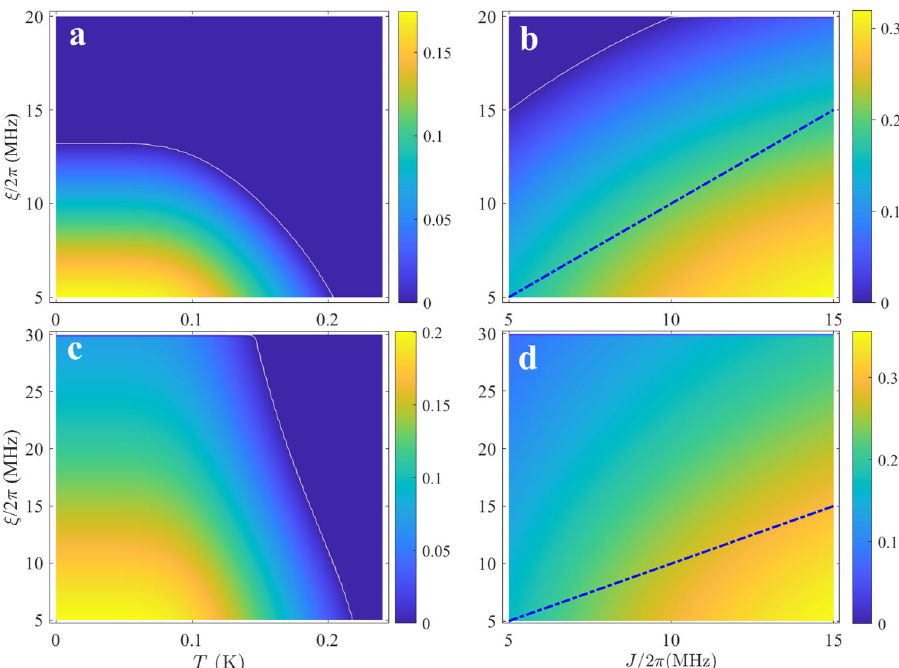
Fig. 5 Robust quantum entanglement and one-way steering. Entanglement E N and steering versus ξ , a , c T and b , d J . The corresponding parameters are J /2 π = 5 MHz in ( a , c ), ξ = κ = γ = Γ in ( a – d ), and the other parameters are the same as those in Fig. 2, where the white contour lines depict the critical temperature and critical coherent coupling of entanglement and steering observability when the dissipation is fi xed to a certain